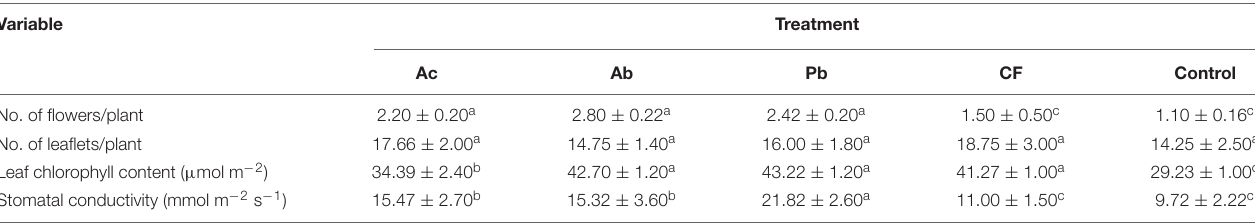
fertilizer, Control = without any soil